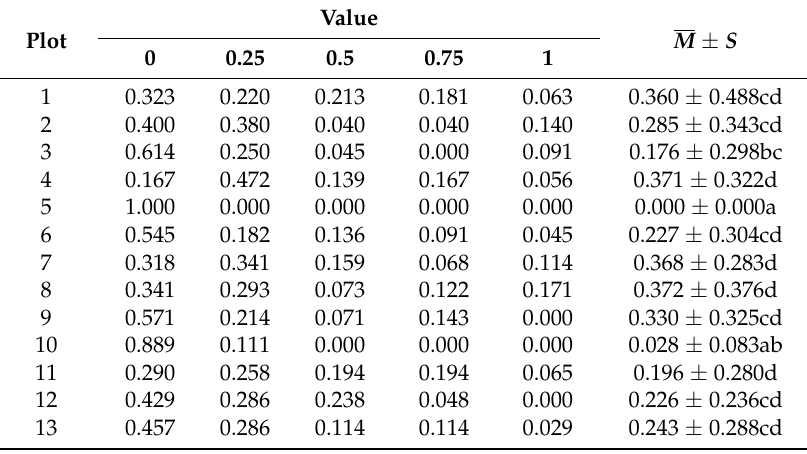
Table 5. Frequency distribution and mean value of M in different plots.